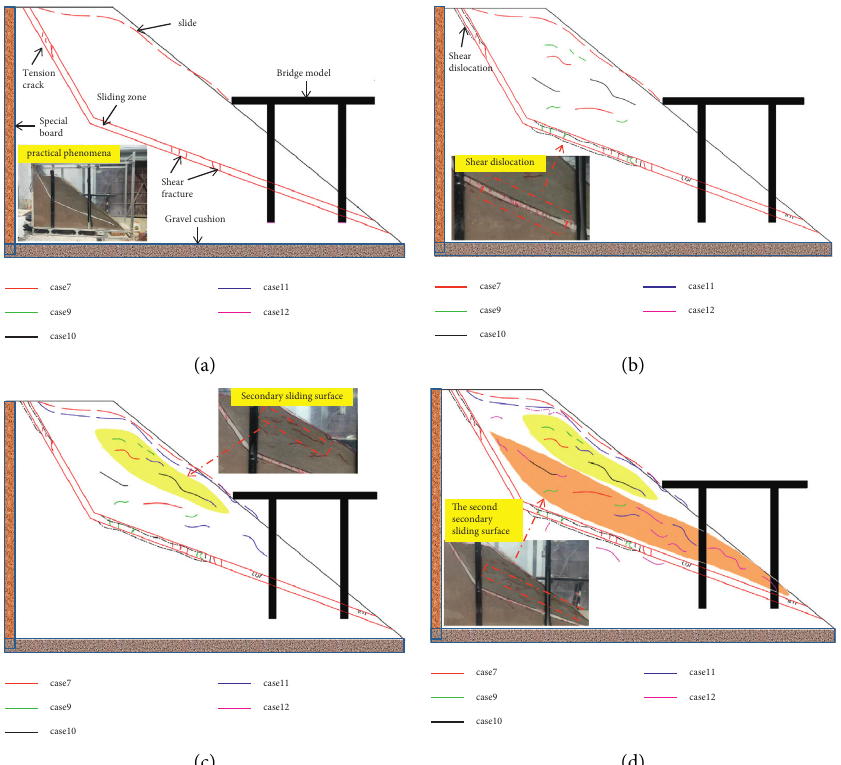
Figure 7: Experimental phenomena of landslides at different stages. (a) Phenomenon of initial slope test. (b) Test phenomenon of case 10 (0.3g). (c) Test phenomenon of case 11 (0.4g). (d) Test phenomenon of case 12